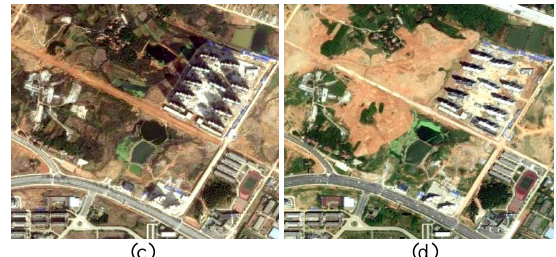
Figure2. The experimental dataset. (a) Image acquired on year 2014; (b) Image acquired on year 2015; (c) T1 zoomed image; (d) T2 zoomed image.